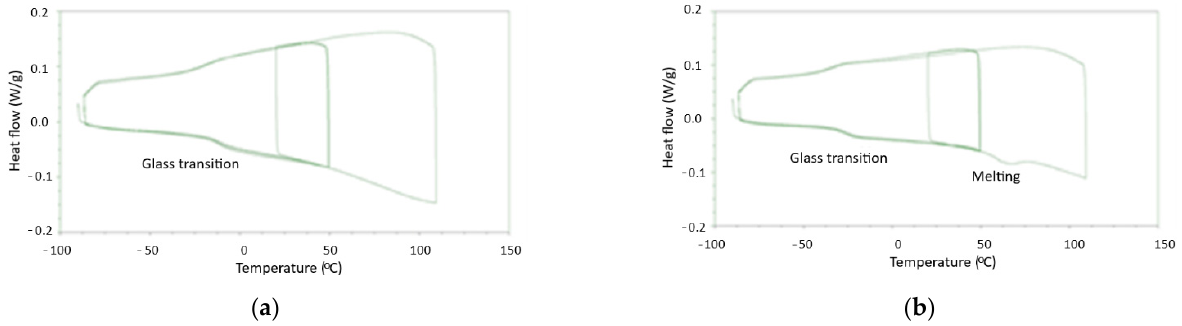
Figure 6. Results of the DSC tests of the rotor blade edge components: ( a ) Bonding ply; ( b ) Rubber.